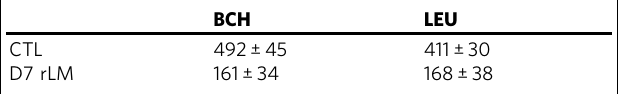
Table 2 IC50 values of BCH and leucine on kynurenine uptake BCH